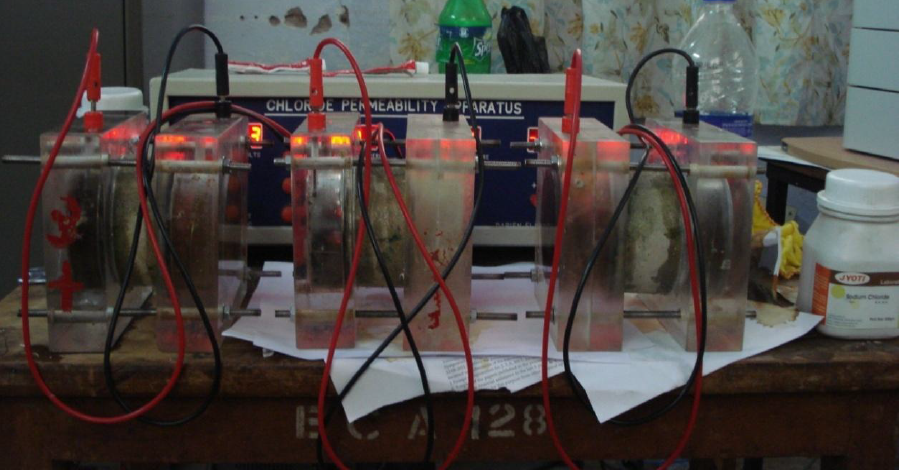
Figure 1. Photographic image of the experimental setup for rapid chloride permeability test.